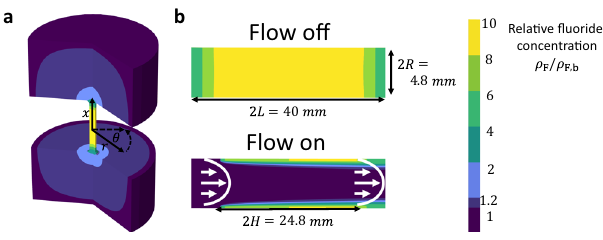
Fig. 5 Channel geometry and numerical solutions to the reaction – diffusion – advection Eqs. (3) – (7). Illustration of the fl ow channel as used for the numerical calculations in COMSOL with resulting concentration pro fi les. The center of the fl ow channel is at the origin ð x ¼ 0 ; r ¼ 0 Þ . The channel length and diameter are 2 L ¼ 40 mm and 2 R ¼ 4 : 8 mm, respectively, and the dissolving surface length is 2 H ¼ 25 mm. The color represents the fl uoride concentration. In a , the result of the numerical calculations in the full three-dimensional model geometry can be seen in fl ow-off conditions. Panel ( b ) is a zoom-in on the channel under fl ow-off conditions (top) and fl ow-on conditions (bottom) at 1 mL·min − 1 in the positive x -direction as also indicated by the parabolic Poiseuille fl ow pro fi le (white arrows). With fl ow, the concentration in the center of the channel essentially equals that in the reservoir. Nonetheless, a signi fi cant diffuse boundary layer remains at the dissolving surface, with a boundary layer thickness of δ ð 0 Þ (cid:8) 0 : 5 mm. The thickness of the boundary layer scales as δ / ð x þ H Þ 1 = 3 . The boundary layer, which is much smaller than the channel radius, reduces the effective advection rate by orders of magnitude, as the fl uid velocity is low near the channel